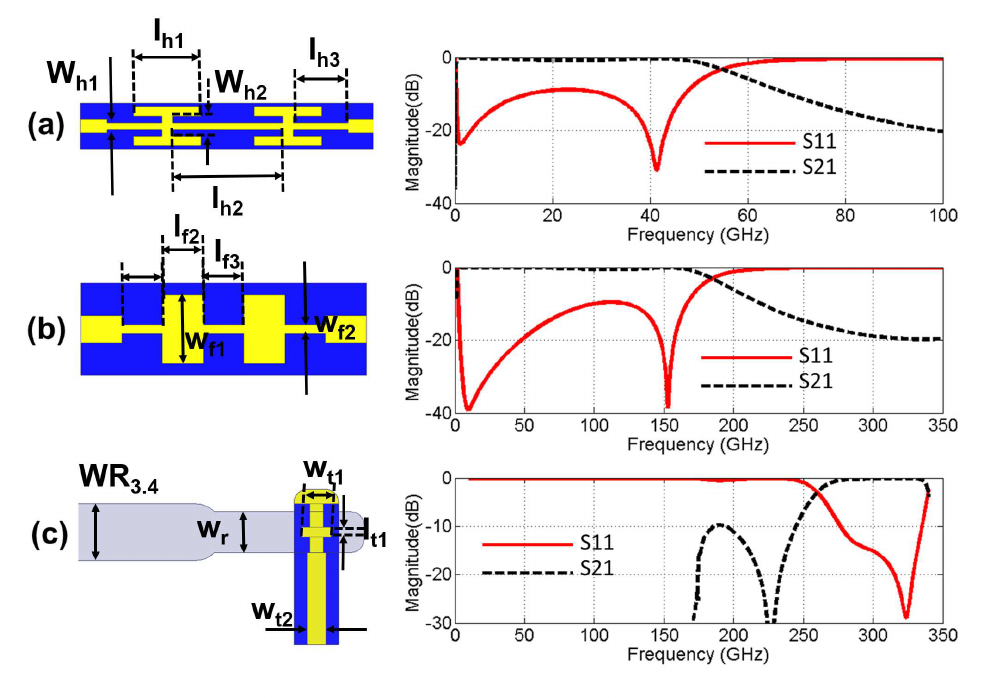
Figure 5. Top view and predicted response of passive circuits used in the subharmonic mixer: ( a ) IF Hammer-head filter, ( b ) Stepped impedance LPF for RF rejection and ( c ) RF E-Probe transition between waveguide and